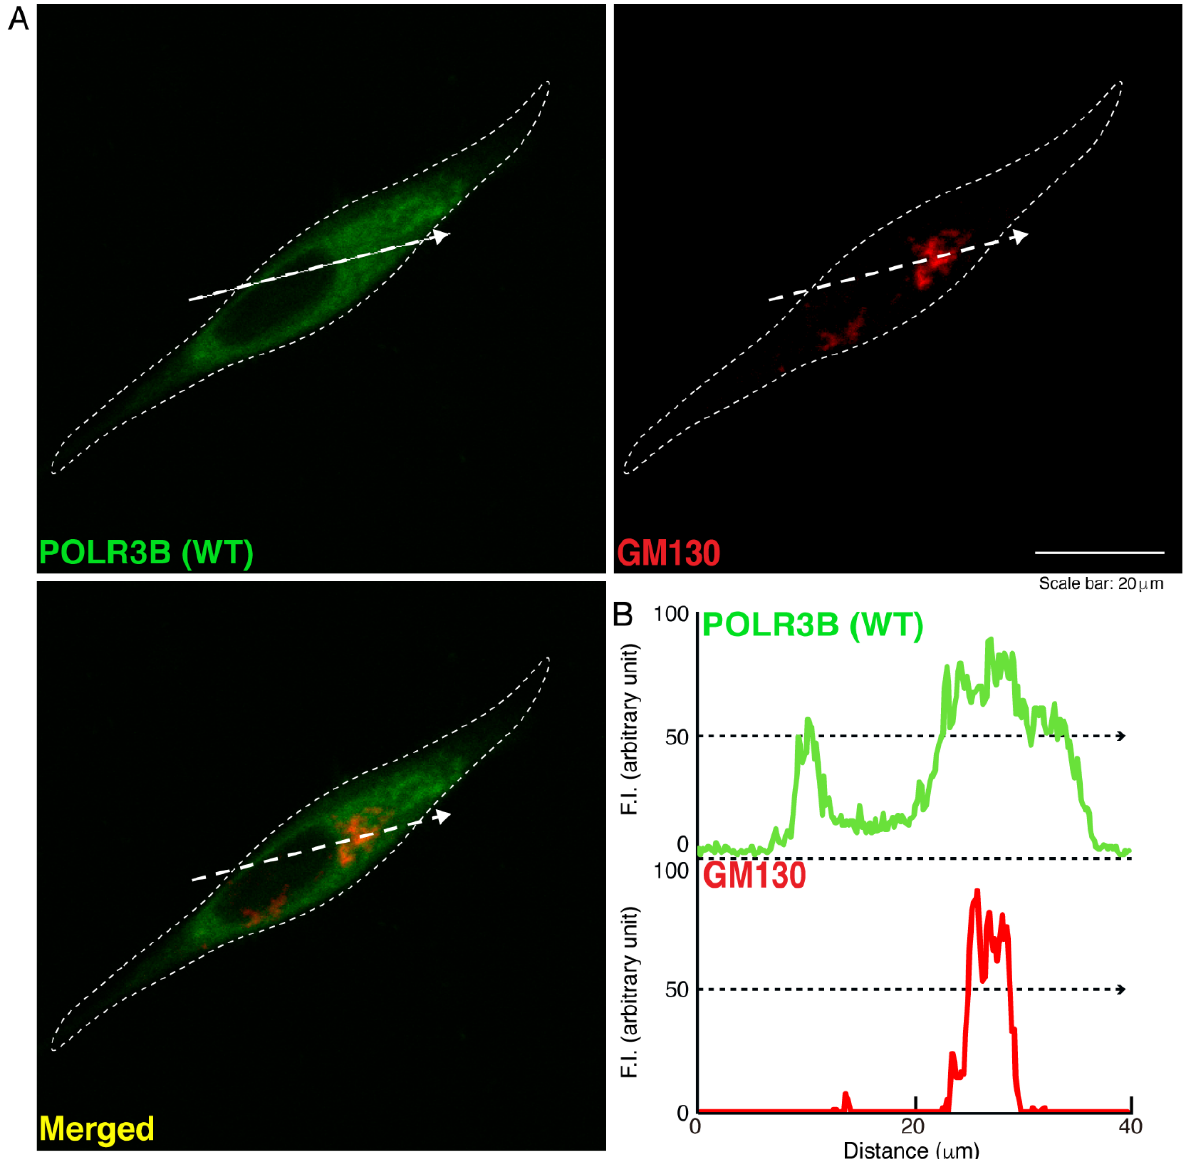
Figure 4. Wild type proteins are not co-localized with the Golgi body in cells. ( A , B ) Cells were transfected with the plasmid encoding the wild type (WT) POLR3B (green) and stained using an antibody against the GM130 antigen (red). Scan plots were performed along the white dotted lines in the direction of the arrows in the color images (green and red as well as merged images). Graphs showing the fluorescence intensities (arbitrary units) along the white dotted lines in the direction of the arrows (black dotted lines in right bottom panels) can be seen in the right bottom panels.